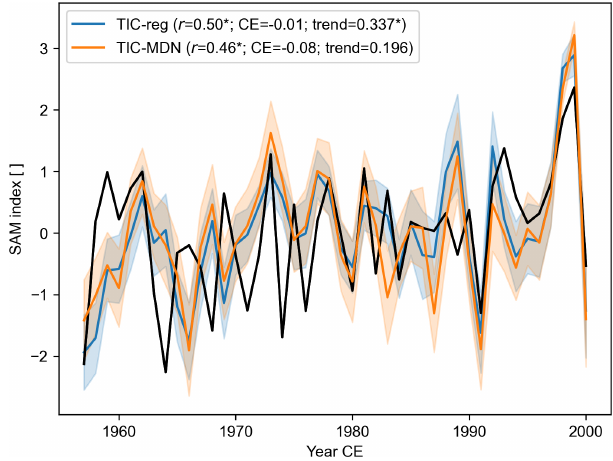
Figure 5. Z -scored (relative to 1957–2000CE) Southern Annular Mode (SAM) index of Marshall (2003) (in black) and reconstructed SAM index (in color) over 1957–2000CE for different DA exper- iments with both ice core and tree-ring proxies (Table 1); Pear- son correlation coefficient ( r ), coefficient of efficiency (CE), and decadal trend of the reconstructed SAM index (trend). Asterisks stand for a significant correlation coefficient or trend at the 95% confidence level. The observed trend of the SAM index is 0.28 ∗ standard deviation per decade over 1957–2000CE. The uncertainty (i.e., the ensemble spread; Sect. 2.1) associated with each recon- struction is represented by the shaded